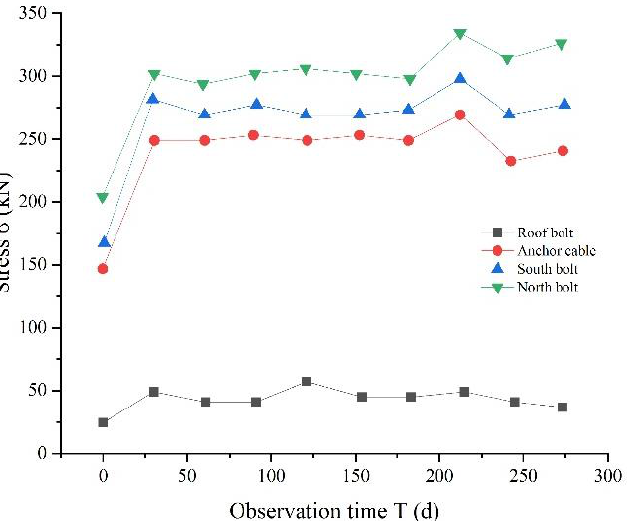
Figure 13. Variation trend of the stress borne by the anchor bolt (cable) in the third group of ergometers in the conveyor roadway of the 360,805 working face.